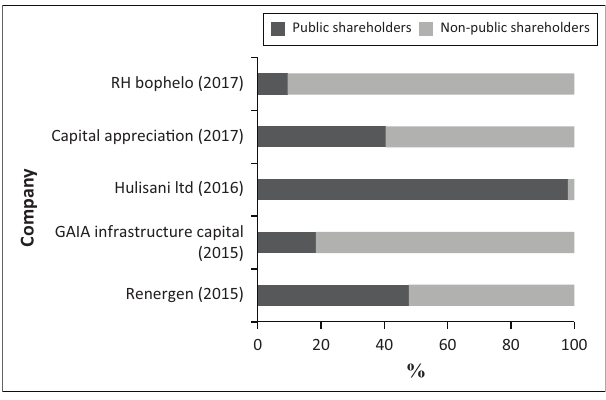
FIGURE 4: Public and non-public